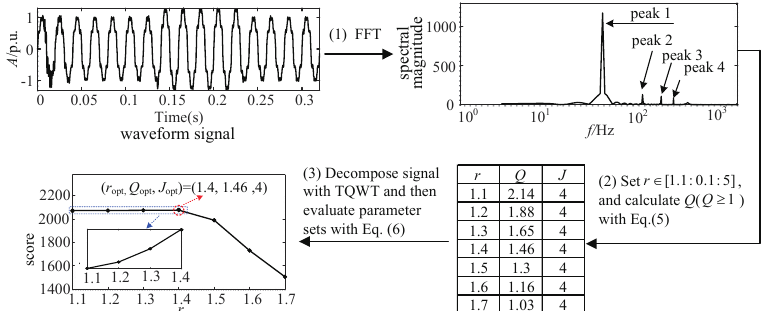
Figure 5. The procedure of parameter selection for TQWT.